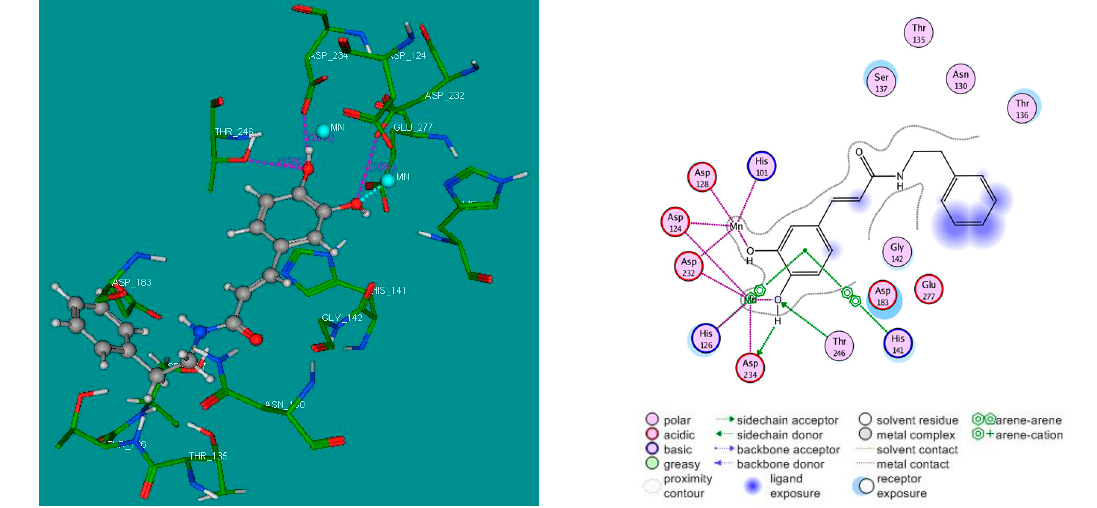
Figure 5. 3D ( left ); and 2D ( right ) binding modes of CAPA ( 1 ) inside the active site of h-ARG I. For the 3D binding mode, CAPA is represented as a “ball and stick” form: C ( grey ), O ( red ), and H ( white ); manganese ions are represented as cyan spheres; and the crucial residues of the binding site are represented by lines. H-bonds are represented as pink dotted lines, while the metal coordination bonds are represented by cyan dotted lines. Docking simulations were performed by FlexX program implemented in LeadIt 2.0.2 software, and the pictures of docking solution were created by MOE 2008.10 software.